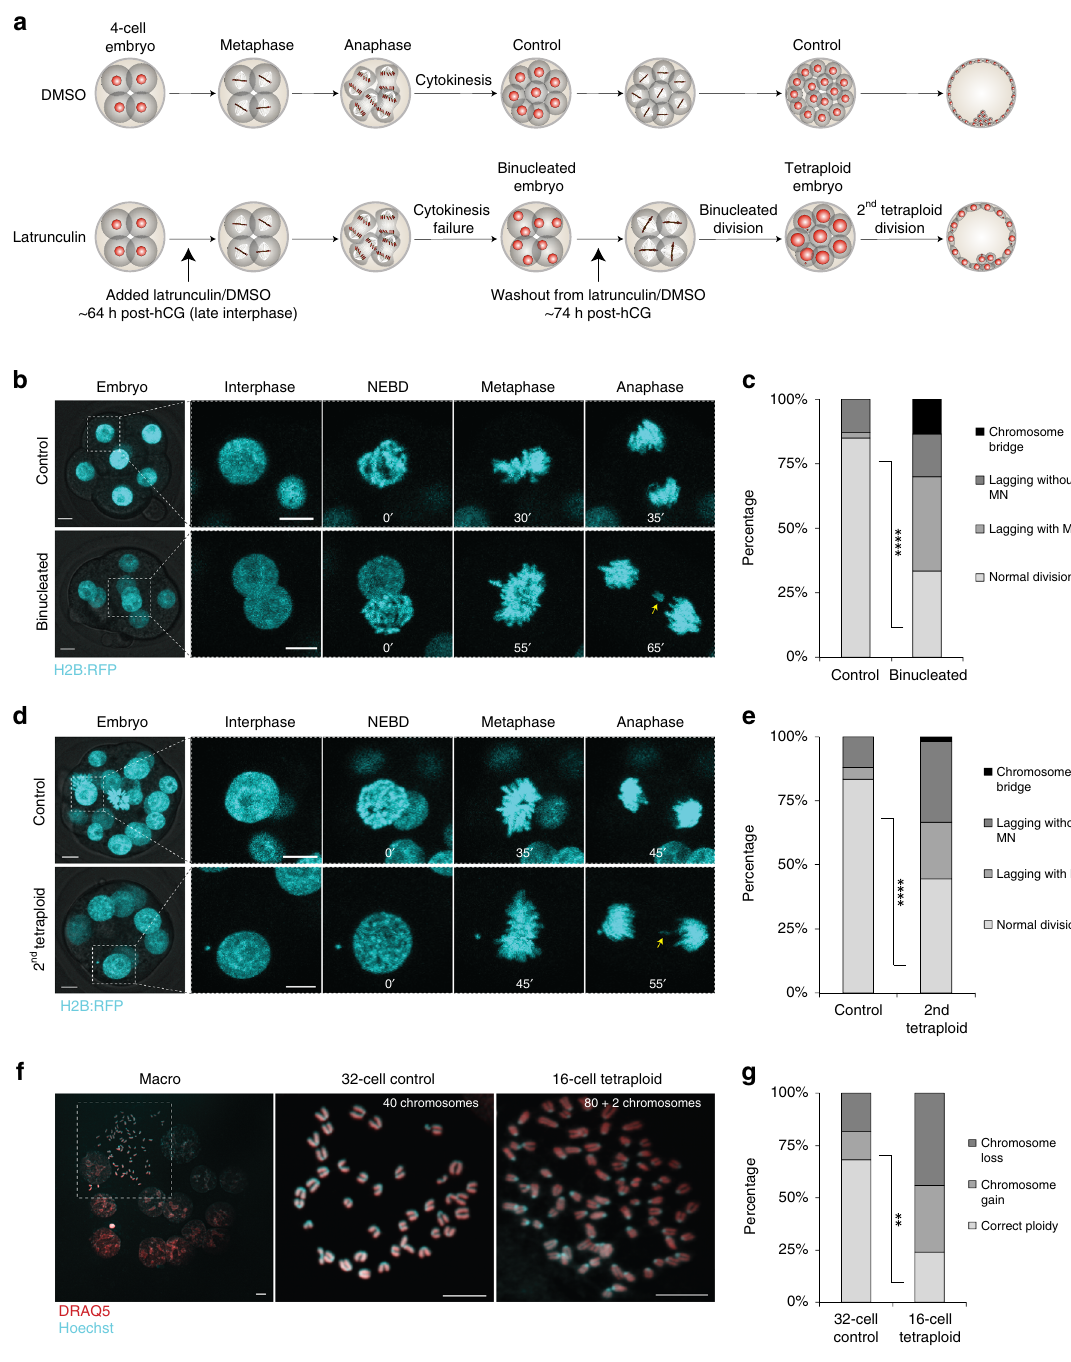
Fig. 1 Tetraploidy leads to chromosomal instability and aneuploidy in the mouse embryo. a Scheme illustrating the experimental design applied for the generation of tetraploid embryos. b and d Representative time-lapse images of mitosis in live H2B:RFP-expressing 8-cell control and 4-cell binucleated b , 16-cell control and 8-cell tetraploid embryos d . A lagging chromosome (yellow arrows) can be observed both in the binucleated and second tetraploid divisions. c and e Percentage of cell divisions containing chromosome segregation errors in 8-cell control ( n = 47 divisions from seven embryos), 4-cell binucleated embryos ( n = 30 divisions from eight embryos) **** P < 0.0001 (two-tailed Fisher ’ s exact test) c ; 16-cell control ( n = 66 divisions from seven embryos) and 8-cell tetraploid embryos ( n = 50 divisions from nine embryos) **** P < 0.0001 (two-tailed Fisher ’ s exact test) e . Chromosome segregation errors observed included: lagging chromosomes resulting in micronuclei formation (lagging with MN); lagging chromosomes that did not result in micronuclei formation (lagging without MN); and chromosome bridges. f Representative images of chromosome spreads obtained from 32-cell control and 16-cell tetraploid embryos. g Percentage of blastomeres containing whole chromosome gains and losses in 32-cell control ( n = 22 spreads) and 16-cell tetraploid embryos ( n = 25 spreads) ** P = 0.0034 (two-tailed Fisher ’ s exact test). Scale bars = 10 µ m. NEBD nuclear envelope